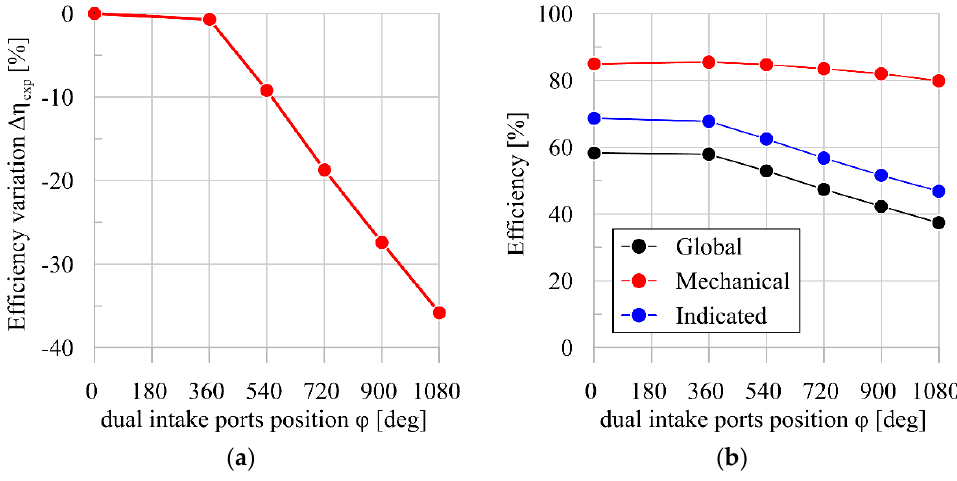
Figure 12. Efficiency variation Δη exp ( a ) and global, mechanical and indicated efficiencies as function of dual intake ports’ position ( b ) of the scroll expander.